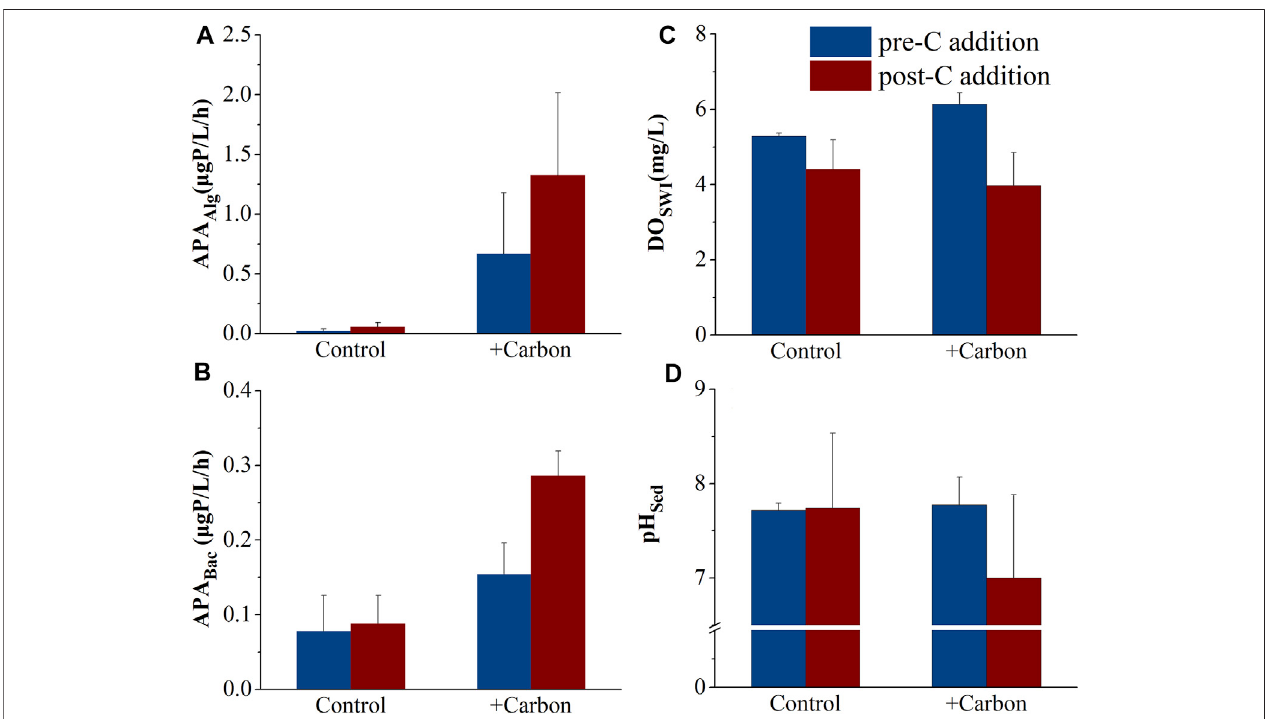
FIGURE 4 | Changes (mean ± SE) in APA Alg (A) , APA Bac (B) , DO SWI (C) , and pH Sed (D) in the various treatments before (day 1, coded as pre-C addition) and after carbonaddition(day56,post-Caddition).APA Alg ,alkalinephosphataseactivityofalgaefraction(µg P L − 1 h − 1 );APA Bac ,alkalinephosphataseactivityofbacterialfraction (µg P L − 1 h − 1 ); DO SWI , dissolved oxygen concentration (mg L − 1 ) at the sediment – water interface; pH Sed , pH of